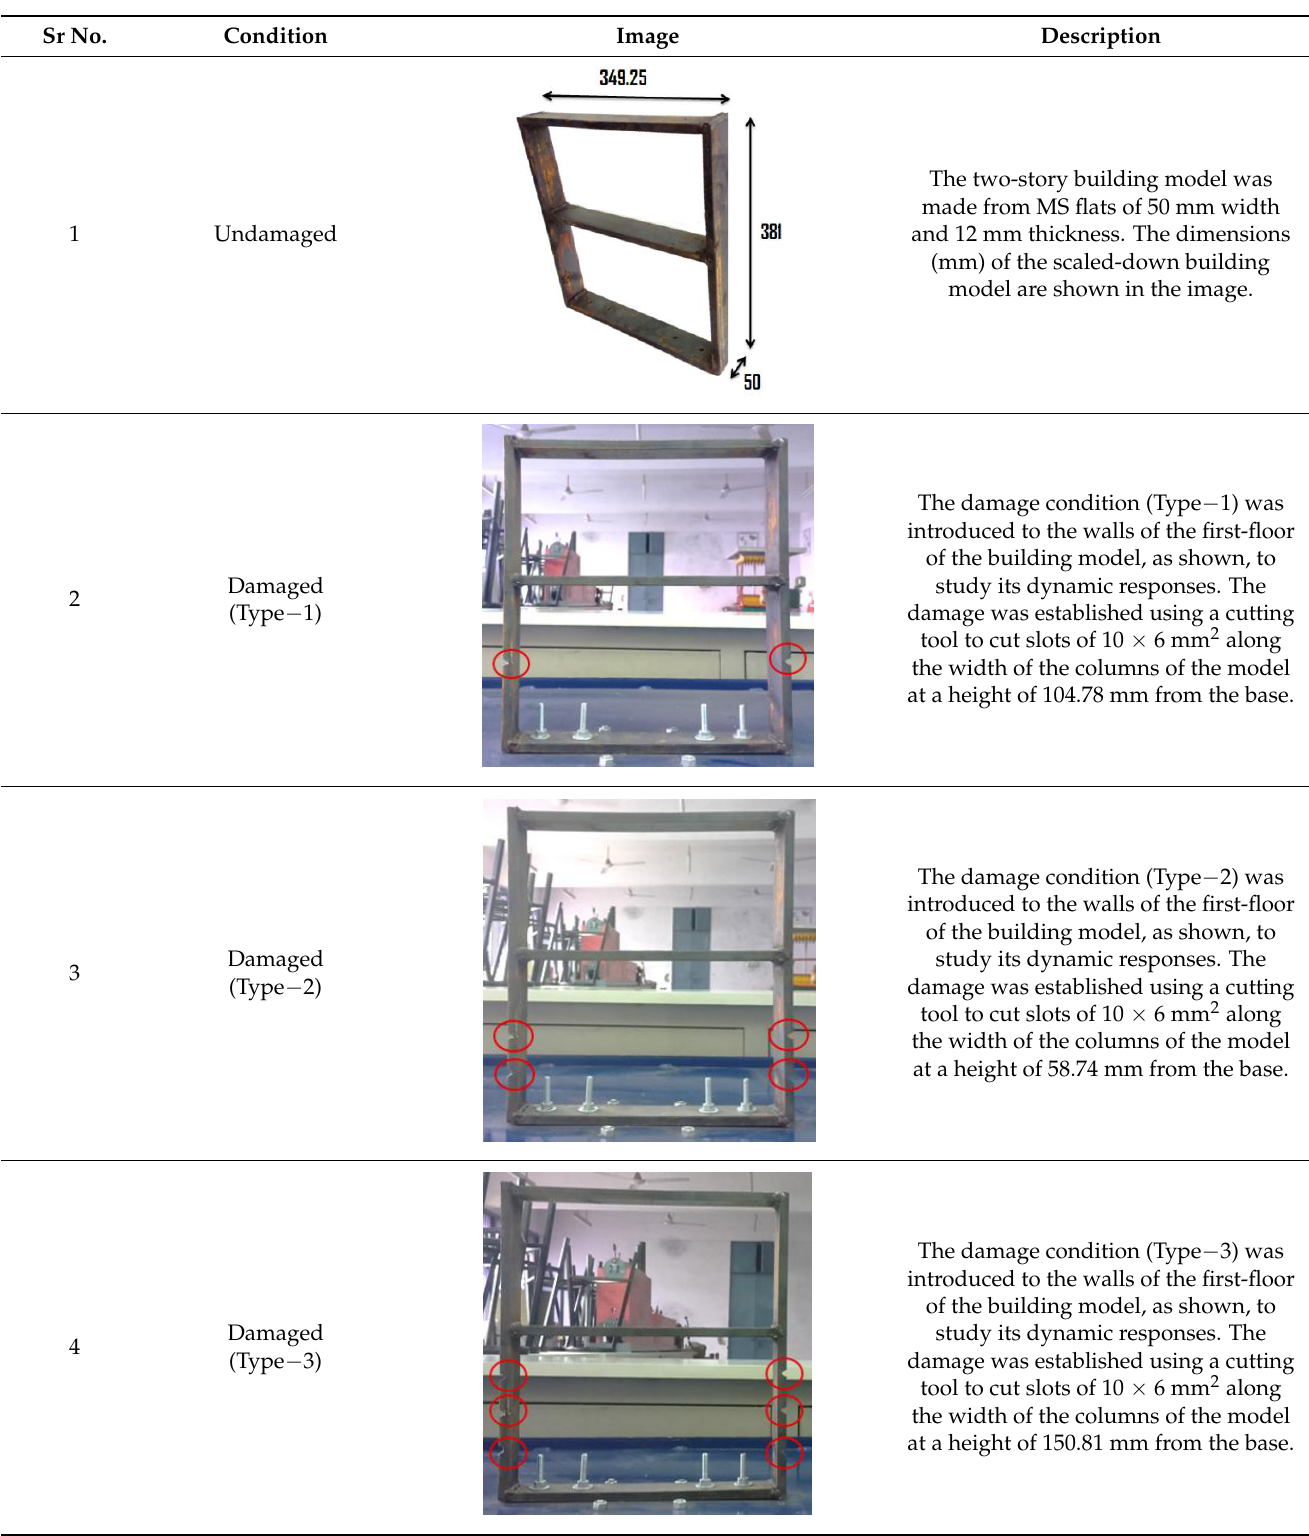
Figure 4. A sample of damage introduced to the building model. Table 2. Damage conditions of the building model (All dimensions are in mm).